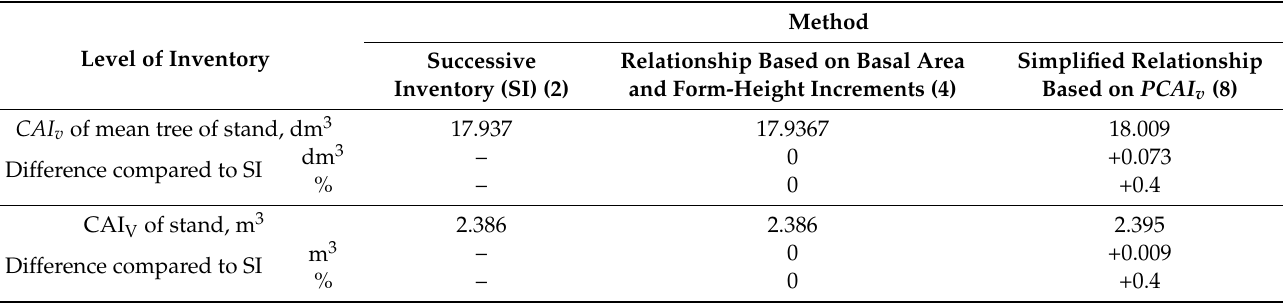
Table 6. Methods used to determine the current annual volume